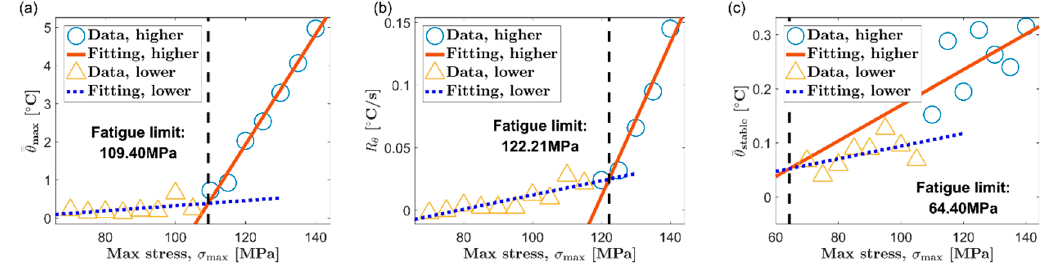
= θ max ; 𝜃̿ = (cid:2929)(cid:2930)(cid:2911)(cid:2912)(cid:2922)(cid:2915) . θ 𝜃̿ stable . (cid:2929)(cid:2930)(cid:2911)(cid:2912)(cid:2922)(cid:2915) . 𝜃̿ (cid:2929)(cid:2930)(cid:2911)(cid:2912)(cid:2922)(cid:2915) .